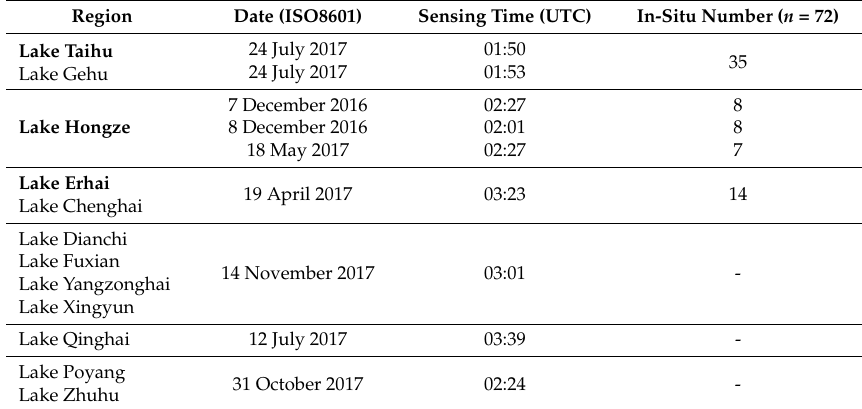
Table 2. List of the image data used in this study. The satellite-synchronous in situ sampling measurements were observed in Lake Taihu, Lake Hongze, and Lake Erhai are in bold